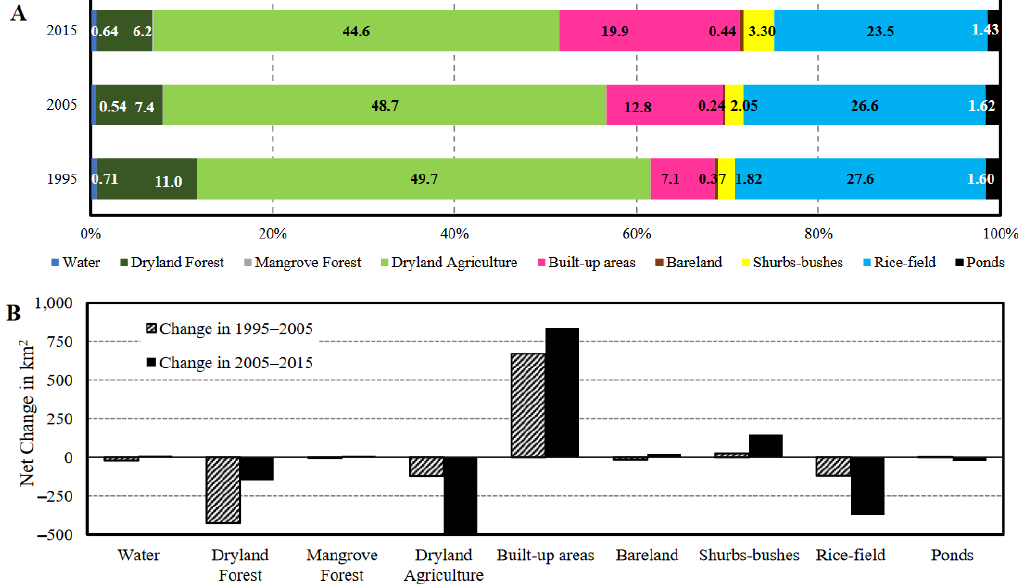
Figure 4. Comparison of changes over land-use classes by: ( A ) percentage of study area, ( B ) gains and losses of area in km 2 . The land-use changes in the BRB vary among cities (Figure 5). Urban expansion and agricultural decline occurred in all cities. The increases in built-up area ranged from 10% to 35%. A lower degree of urbanization (less than 15%) generally occurred in bigger cities than in smaller cities where agricultural land-uses are more evident. This might indicate bigger cities experience urban verticalization (leading to increasing population density without proportional increases in land-coverage).